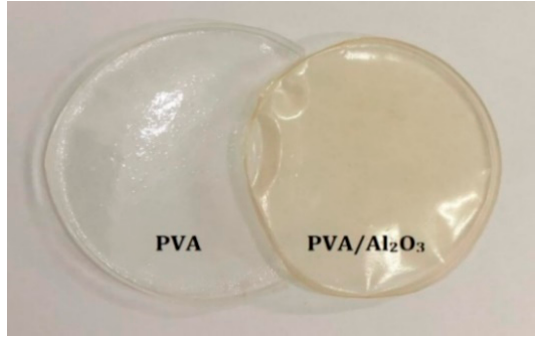
Figure 6. Images of virgin PVA and PVA-Al 2 O 3 nanocomposite.